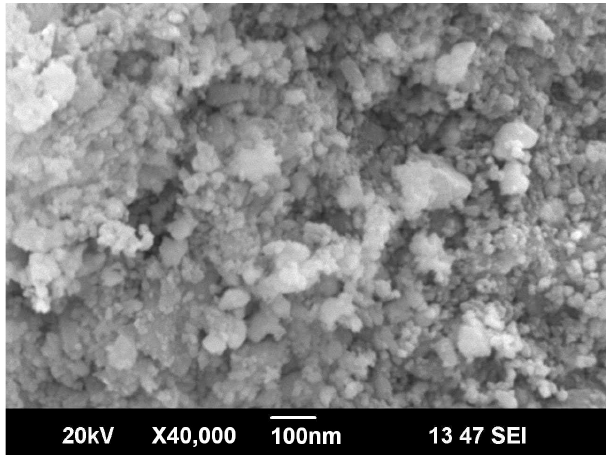
Fig. 2. SEM morphology of Pb 2 Sr 2 CaCu 2 O 9